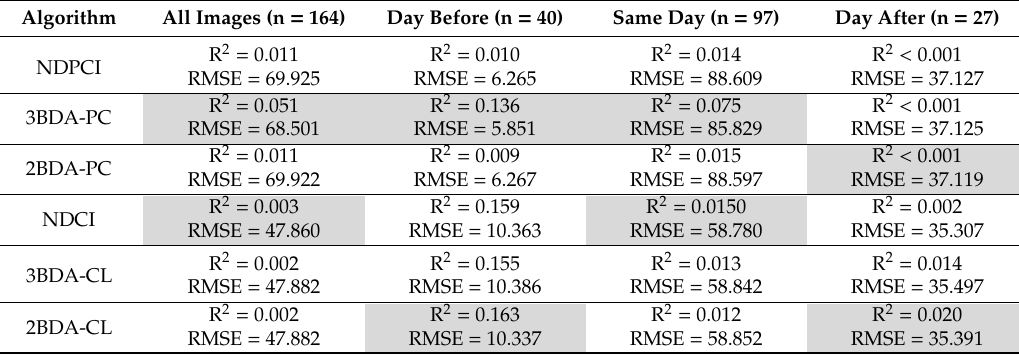
Table 3. Statistical estimators for each algorithm for chlorophyll- a (chl- a ) and PC